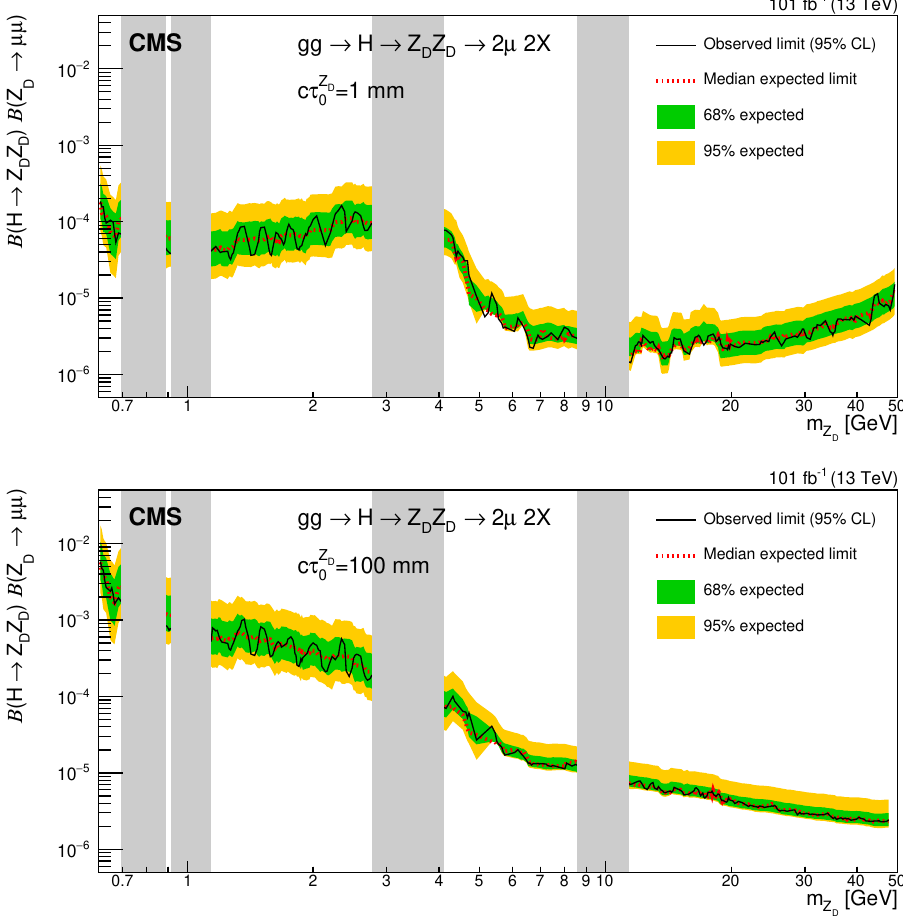
Z ) B (Z Figure 7 . Exclusion limits at 95% CL on the branching fraction product B (H → Z → mm ) , D D D as functions of the signal mass ( m ) for cτ Z D = 1 mm (upper) and 100 mm (lower). The solid Z D 0 black (dashed red) line represents the observed (median expected) exclusion. The inner green (outer yellow) band indicates the region containing 68 (95)% of the distribution of limits expected under the background-only hypothesis. At m & 5 GeV the bands are asymmetrical, due to the small Z D number of events observed in the corresponding search bins, especially those with l > 0 . 2 cm. The xy vertical gray bands indicate mass ranges containing known SM resonances, which are masked for the purpose of this search. The limits are obtained using the combination of all dimuon event